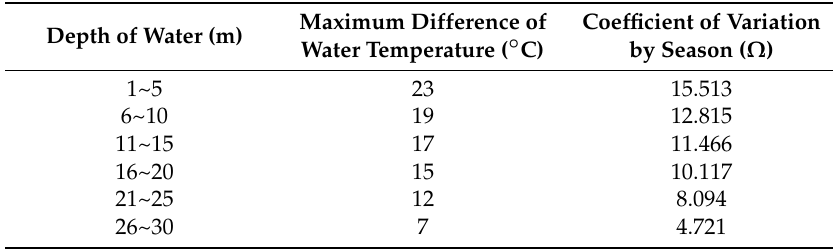
Table 3. Coefficients of variation by season.